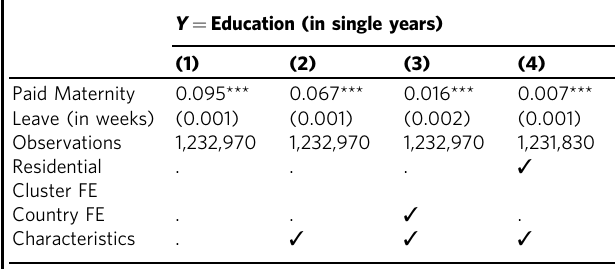
Table 2 The impacts of paid maternity leave on education.